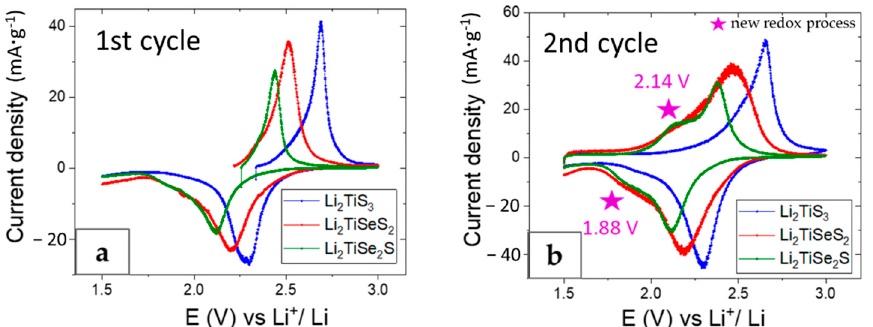
Figure 5. Redox potentials comparison of Li 2 TiS 3 , Li 2 TiSeS 2 , and Li 2 TiSe 2 S electrodes at the first (5 μ V  s − 1 ) ( a ), and second (10 μ V  s − 1 ) ( b ) cycles between 3 and 1.5 V vs. Li + /Li . (5 µ V · s − 1 ) ( a ), and second (10 µ V · s − 1 ) ( b ) cycles between 3 and 1.5 V vs. Li + /Li.